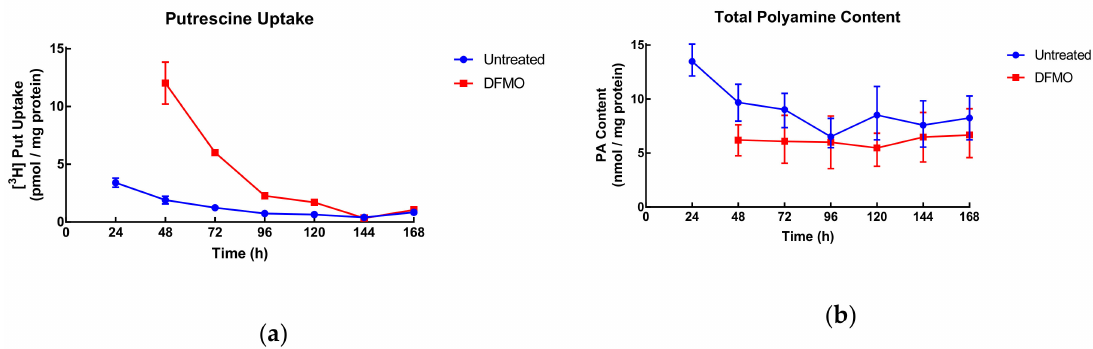
Figure 5. Uptake of putrescine (a) and total intracellular polyamine content (b) of SW480 cells. Cells were seeded at 2.4 × 10 4 cell / cm 2 on 24-well plates for uptake or 6-cm dishes for polyamine content analysis and grown for di ff erent times. Where indicated, cells were pre-treated with DFMO (5 mM) for 24 h. After the indicated growth time, 6-cm dishes were harvested for polyamine content analysis by LC-MS, and radiolabelled putrescine (2.4 nM) with a final radioactivity of 5.55 kBq / well was added to the 24-well plates and cells were incubated for one hour. Uptake was measured by liquid scintillation spectrometry Values are mean with range ( n = 2) with duplicates for each